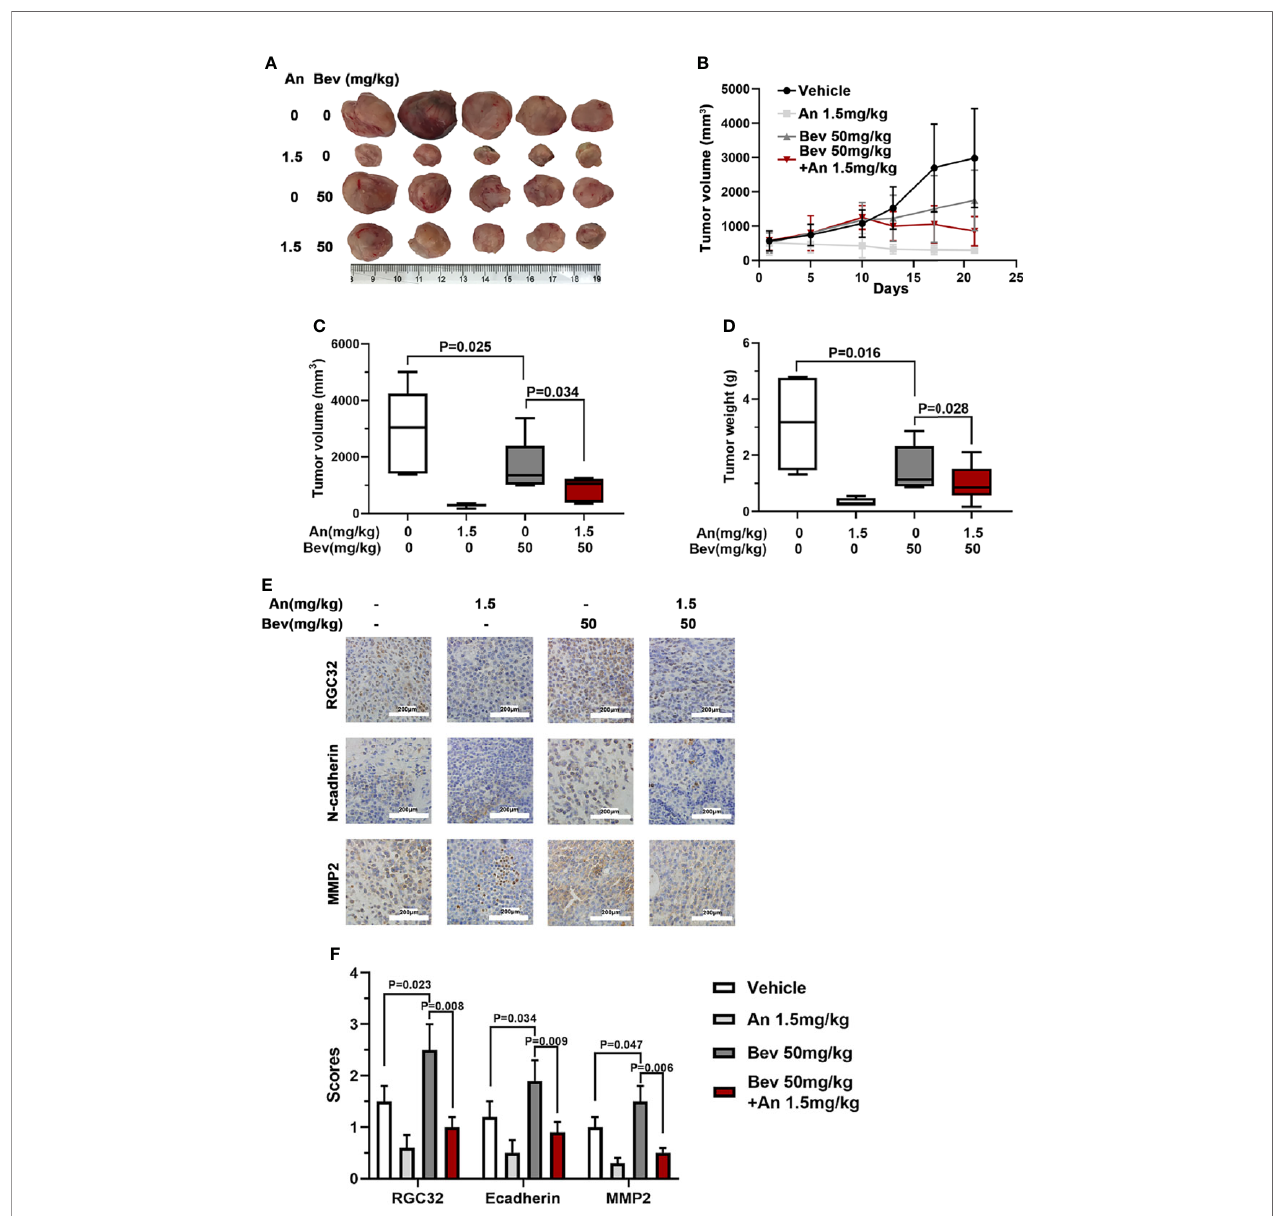
FIGURE 5 | Anlotinib abolishes the effect of bevacizumab and downregulates RGC32, N-cadherin, and MMP2 expression in tumors of mice. (A) Typical image of the primary tumors that formed in mice grafted with A549 cells on the right shoulder, which were treated with bevacizumab, anlotinib or both. Ruler unit: cm. (B) Tumor growth curves for each group. (C) Column diagram of the tumor volume for each group. n = 5. (D) Column diagram of the tumor weight for each group. n = 5. (E) IHC to detect RGC32, N-cadherin and MMP2 in primary tumors. Representative images are shown. Magni fi cation ×400. (F) Column diagram of IHC scores in each group. Each column is the average of fi ve random fi elds per tumor. n = 5. Bev, bevacizumab; An,